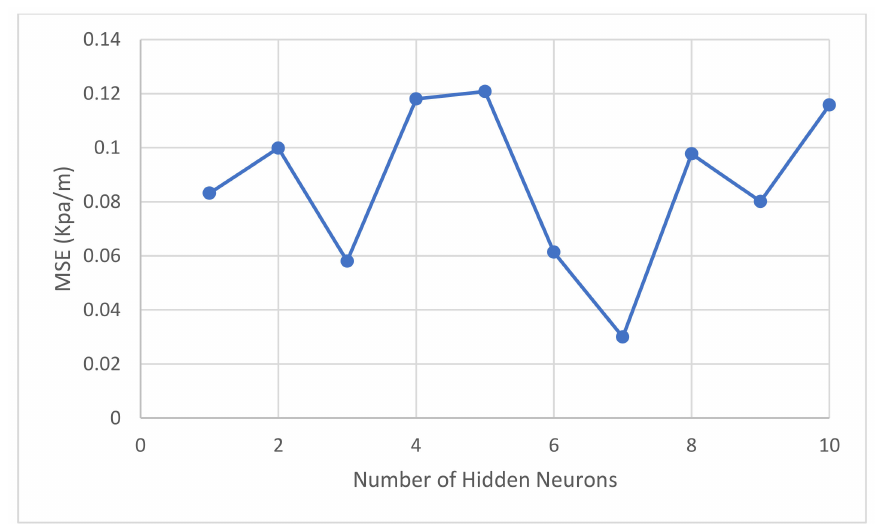
Figure 4. Performance of ANN with different number of hidden